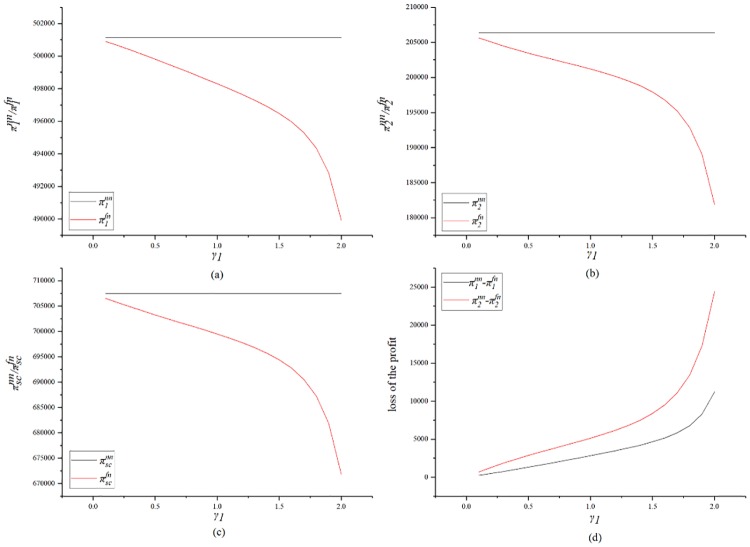
Impact of γ1 on the profits.